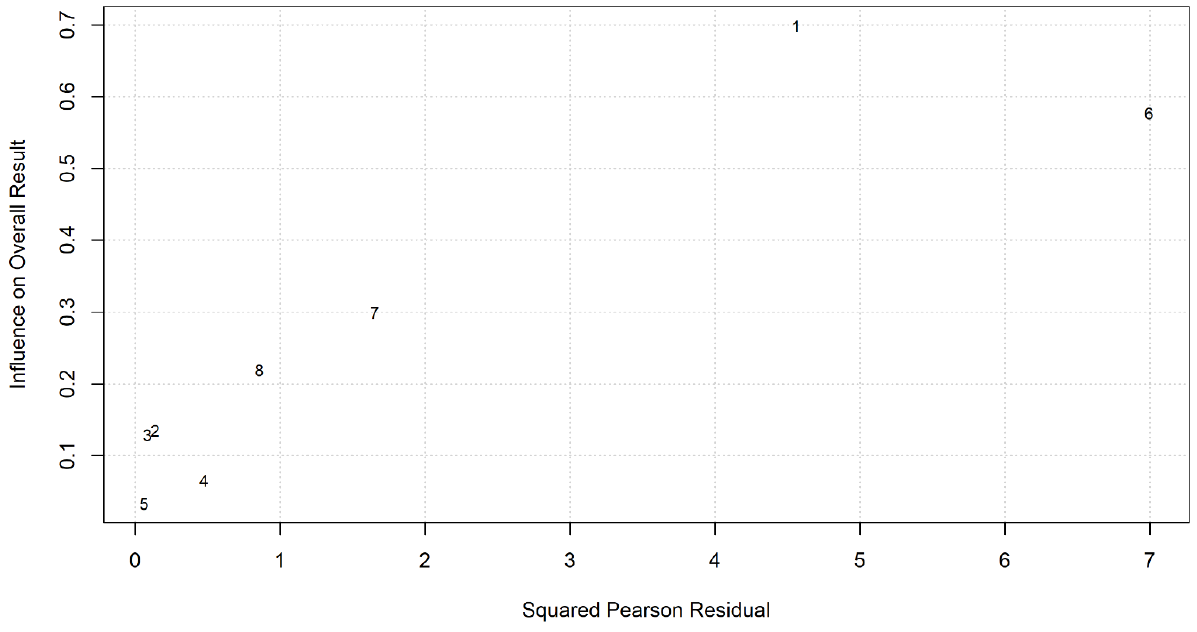
Figure 2. Forest plot of the effect size of NiBS on craving scores. Cardullo et al. 2019 [103], Del Mauro et al. preprint [98], Gay et al. [102], Pettorruso et al. [104], Rosenberg et al. [105], Salerno et al. [106], Zack et al. [81].